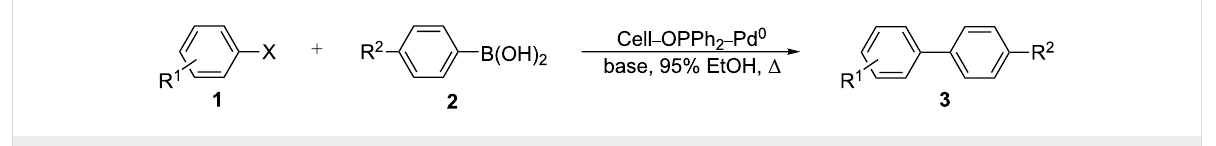
Scheme 3: Reaction of aryl halides with arylboronic acids.